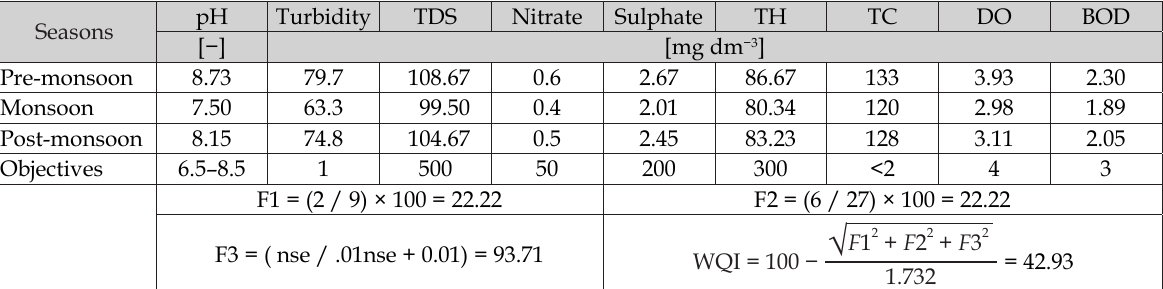
Table 2. Determination of WQI using CCME method.